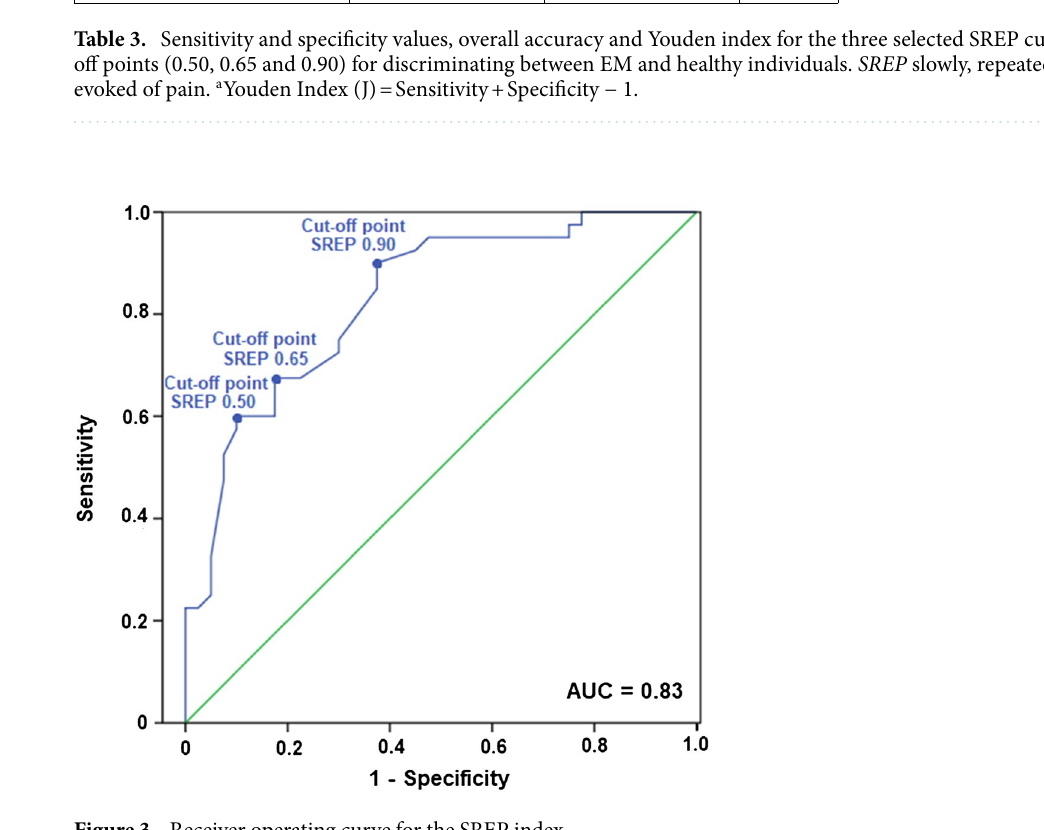
Figure 3. Receiver operating curve for the SREP